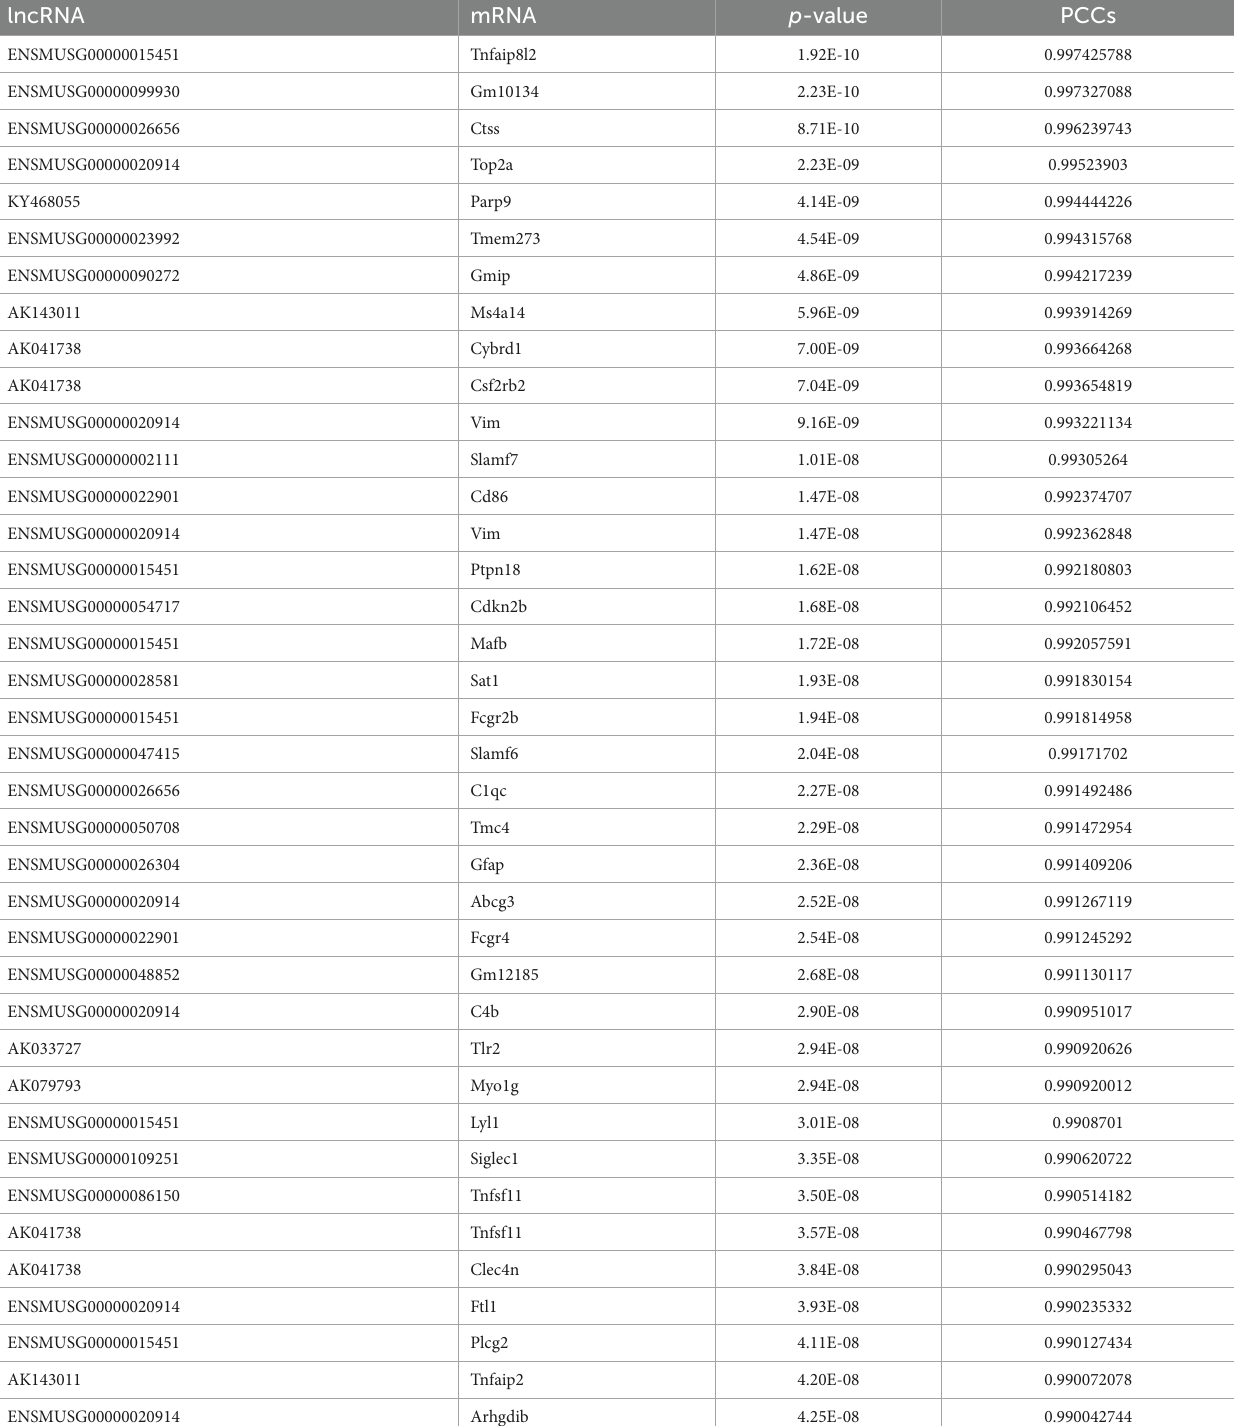
TABLE 6 LncRNA-mRNA co-expression pairs. (|PCCs| >